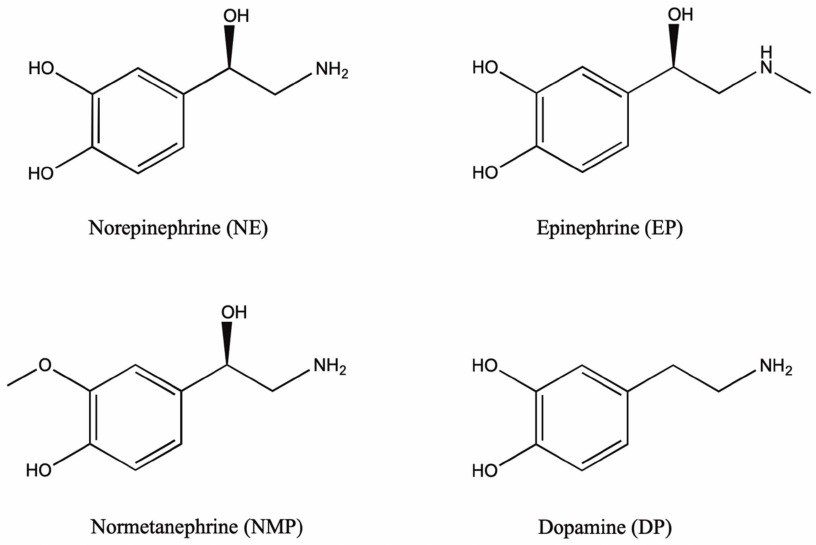
Figure 3. Norepinephrine (NE), epinephrine (EP), dopamine (DP) and normetanephrine (NMP)